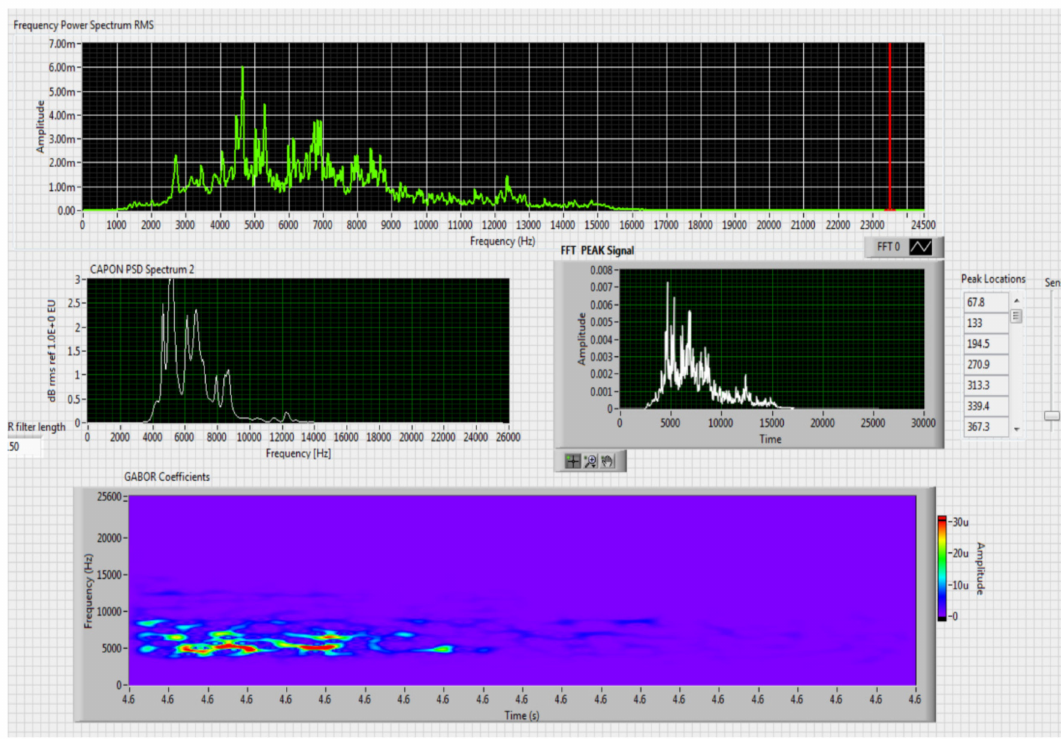
Figure 13. Results obtained for stationary distance 150 m, altitude 10 m.